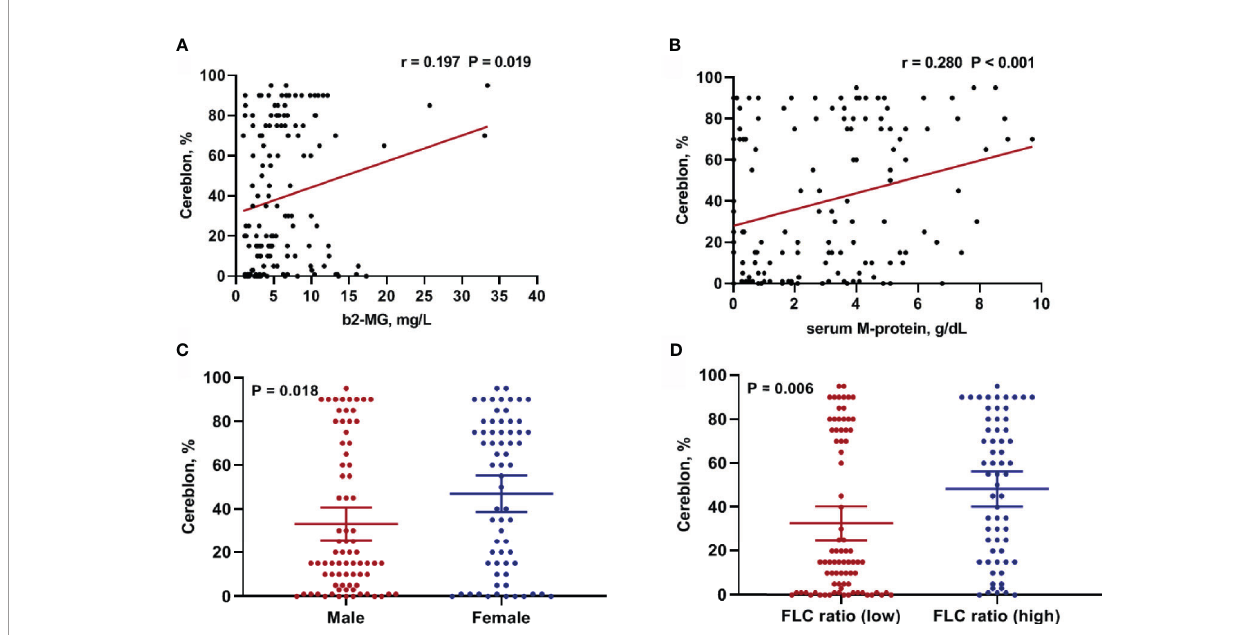
FIGURE 2 | Clinical factors associated with CRBN expression in multiple myeloma patients. Correlation between CRBN expression and (A) b 2-microglobulin as well as (B) serum M-protein levels. Comparison of CRBN expression based on (C) sex and (D) serum FLC ratio. Female patients and patients with high FLC ratio showed signi fi cantly higher CRBN expression level compared to male patients and patients with low FLC ratio. FLC, free-light